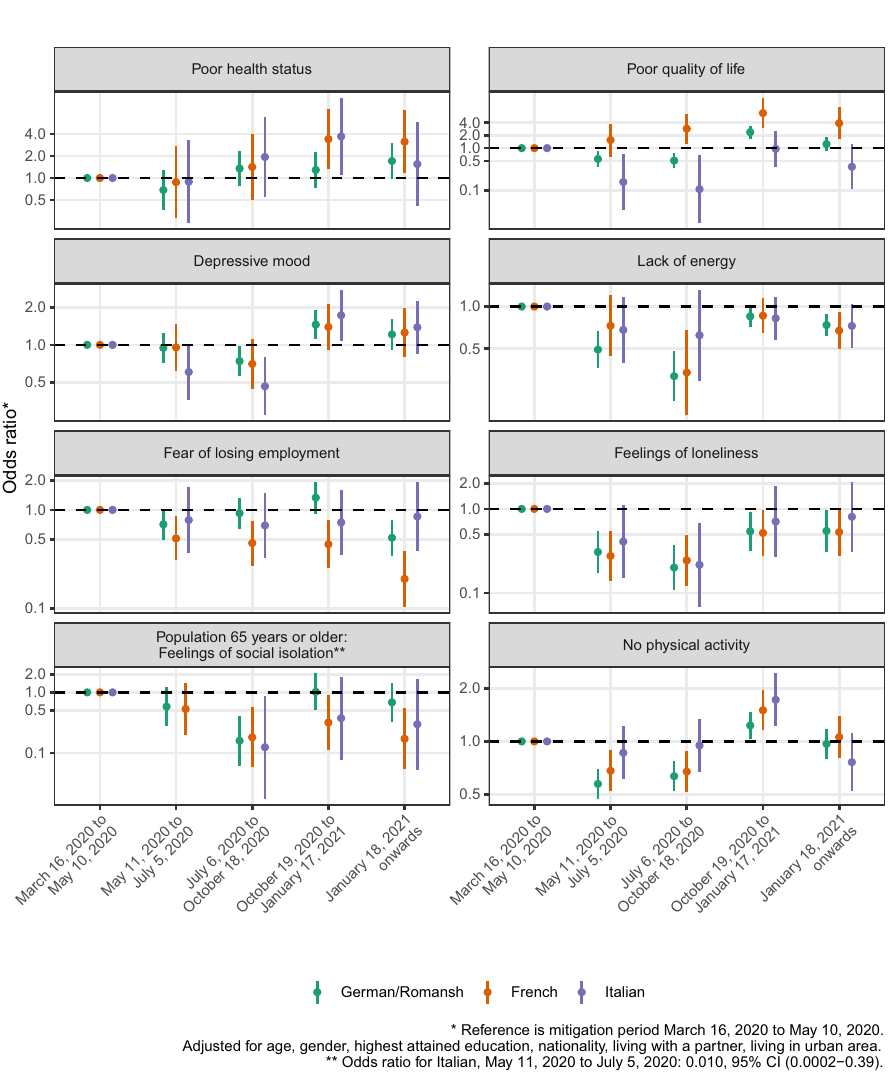
Fig 6. Results from adjusted hierarchical logistic regression models for the study outcome domains of health, loneliness/isolation and physical activity, by mitigation period and language region.